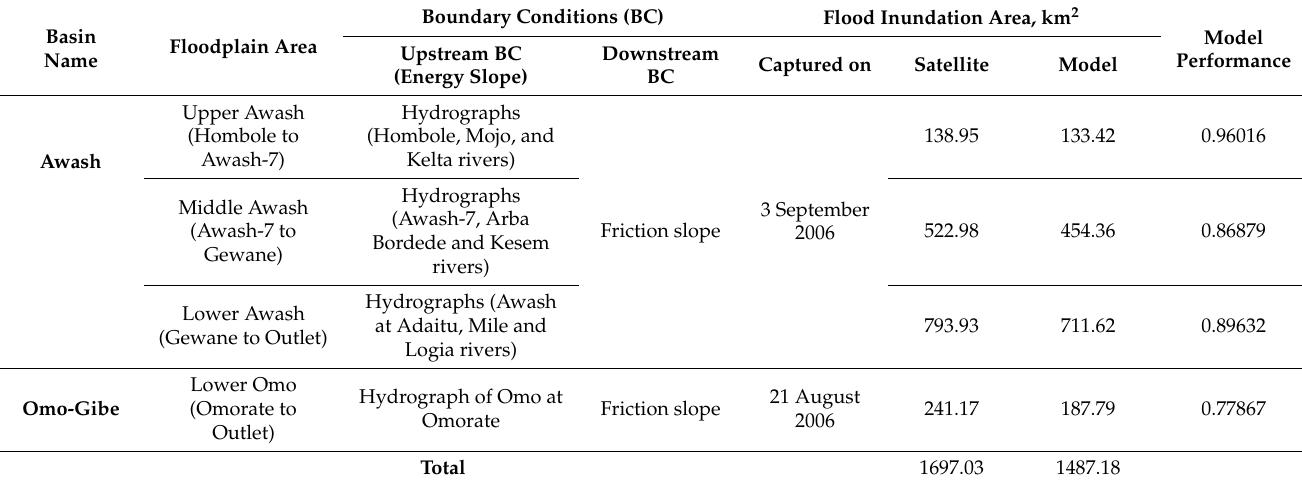
Table 2. Flood inundations in the model basins based on model and satellite observations.